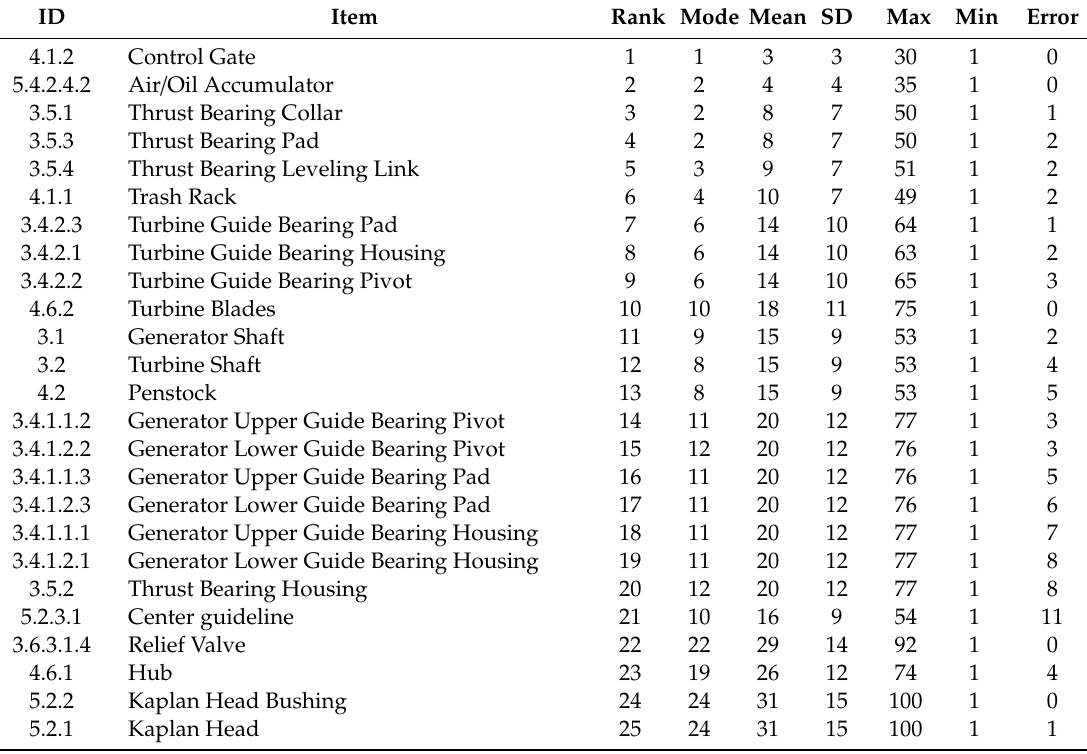
Table 12. Uncertainty Analysis